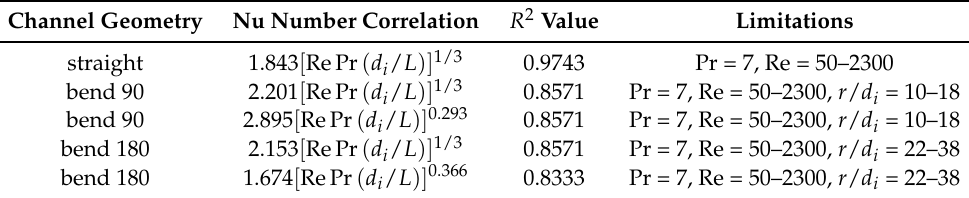
Table 2. Determined correlations for individual geometries and their